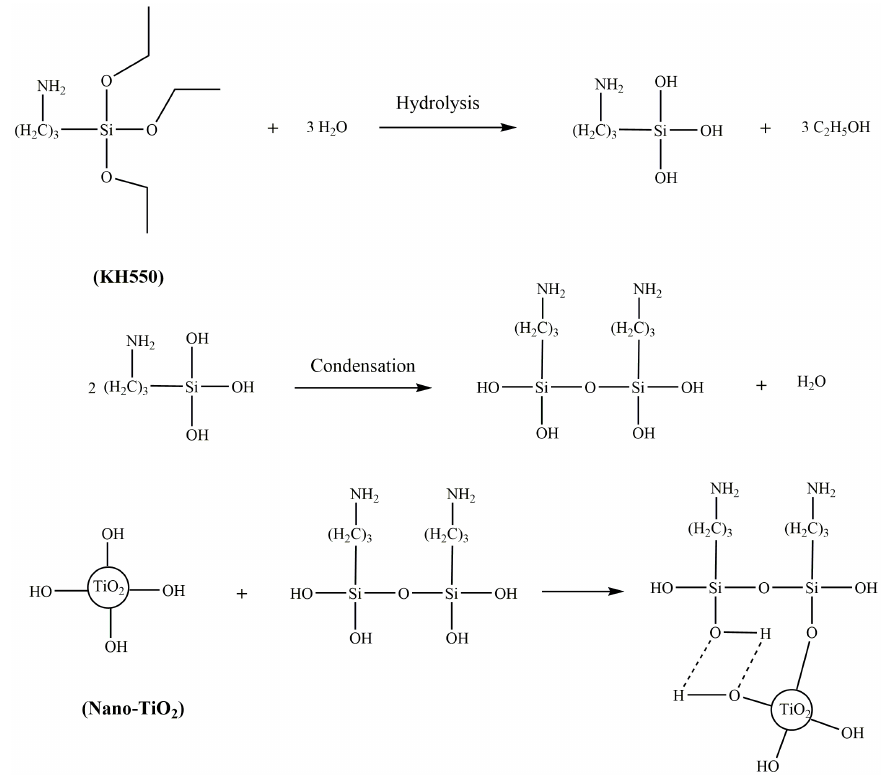
Figure 1. The synthesis of TiO 2 -KH550.